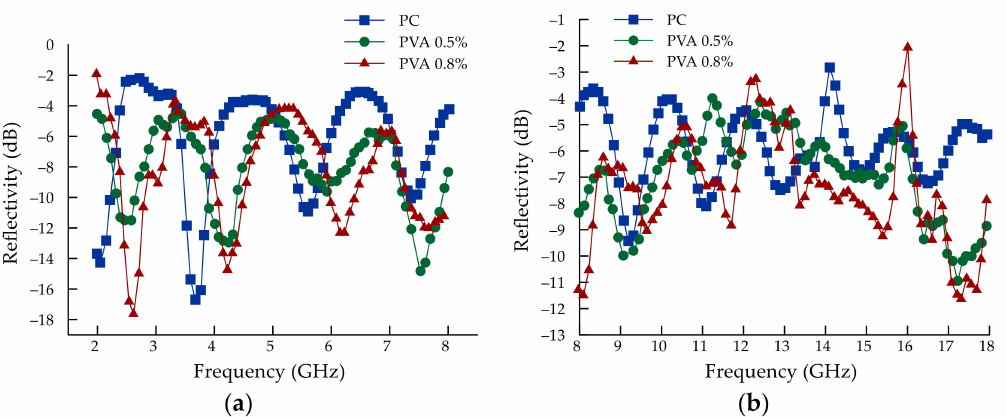
Figure 6. Reflectivity curve for concrete reinforced with PVA fibers: ( a ) reflectivity of the S and C wavebands, and ( b ) reflectivity of the X and KU wavebands (after